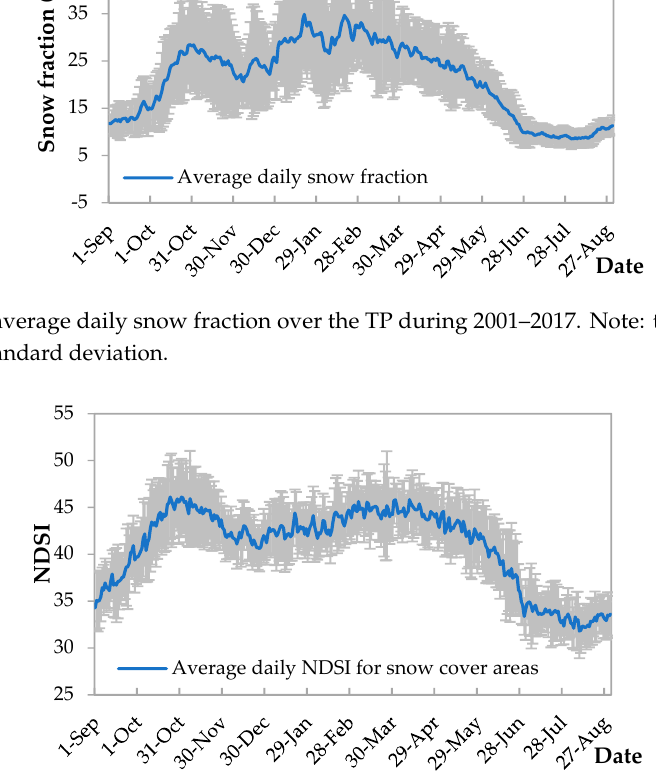
Figure 12. The average daily normalized difference snow index (NDSI) for snow-covered areas over the TP during 2001–2017. Note: the gray error bars represent the standard deviation.